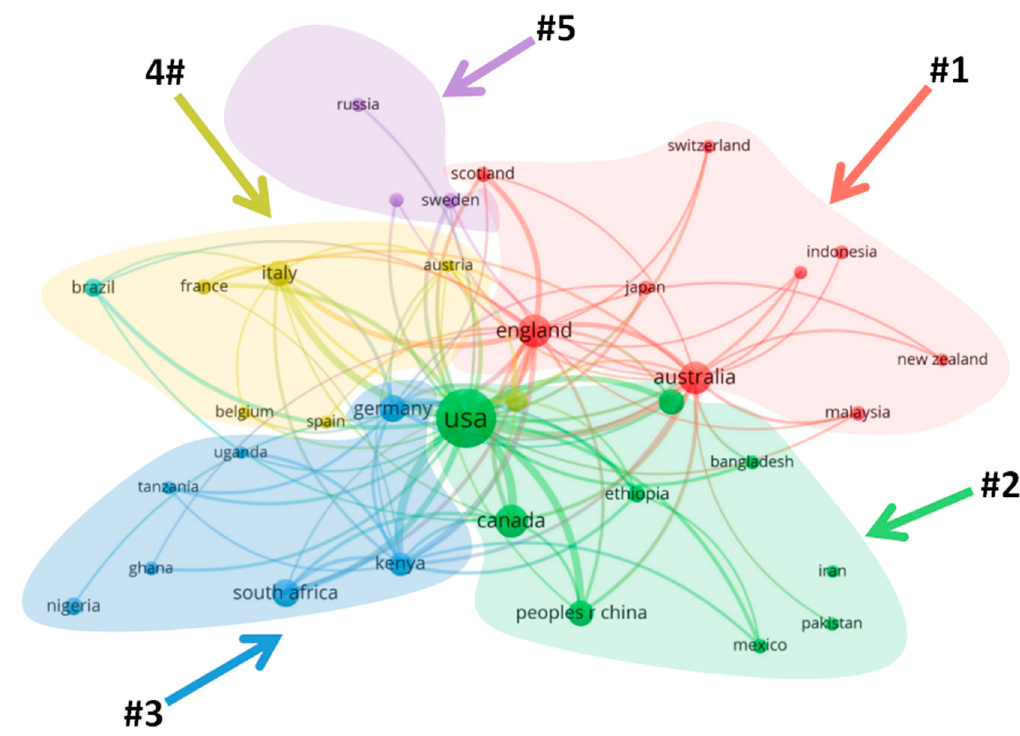
Figure 6. National cooperation networks.